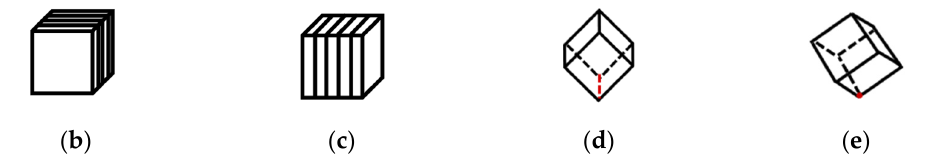
Figure 3. Sintering directions of cubes and their illustrations: ( a ) on xy surface; ( b ) on xz surface; ( c ) on yz surface; ( d ) on an edge; ( e ) on a point.